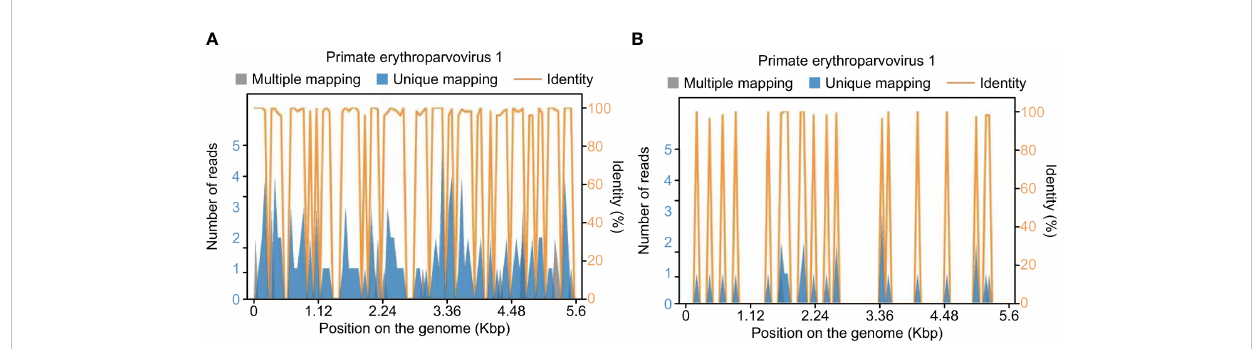
FIGURE 2 Human Parvovirus B19-speci fi c nucleic acids were detected in mNGS samples of serum and blister fl uid. Sequence distribution map: This part only shows the sequence distribution map of species with ≥ 3 nonrepeat speci fi c sequences detected. (A) Serum samples. The total length covered on the genome is 3623 bp, the coverage is 64.7427%, and the average depth is 1.65X. (B) Blister fl uid samples. The total length covered on the genome is 1059 bp, the coverage is 18.9242%, and the average depth is